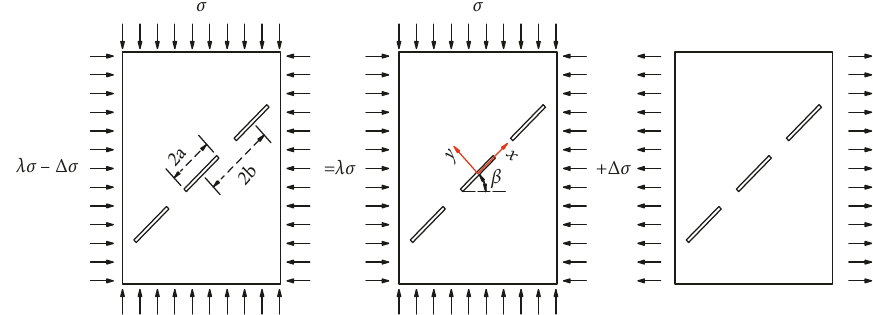
Figure 9: Unloading stress field.